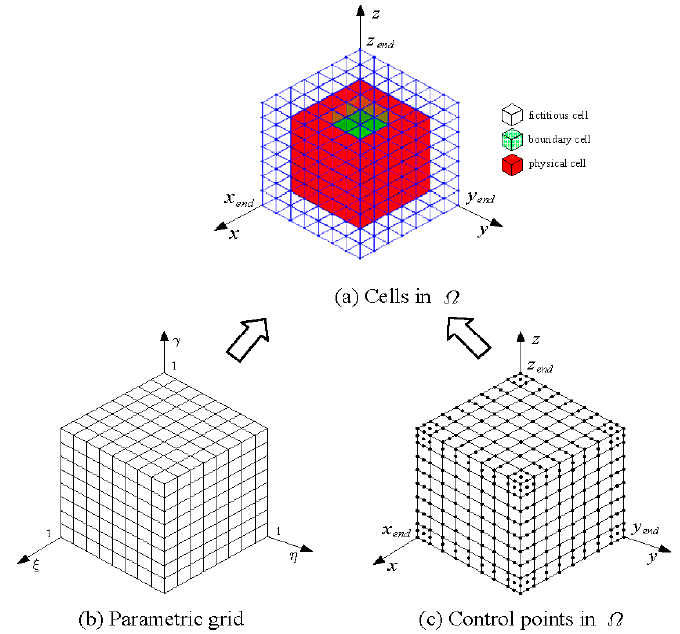
Figure 4. The outline of B-spline FCM: ( a ) cells in Ω and finite cell classification; ( b ) parametric grid; ( c ) grid of control points in Ω with polynomial degree p = q = r =